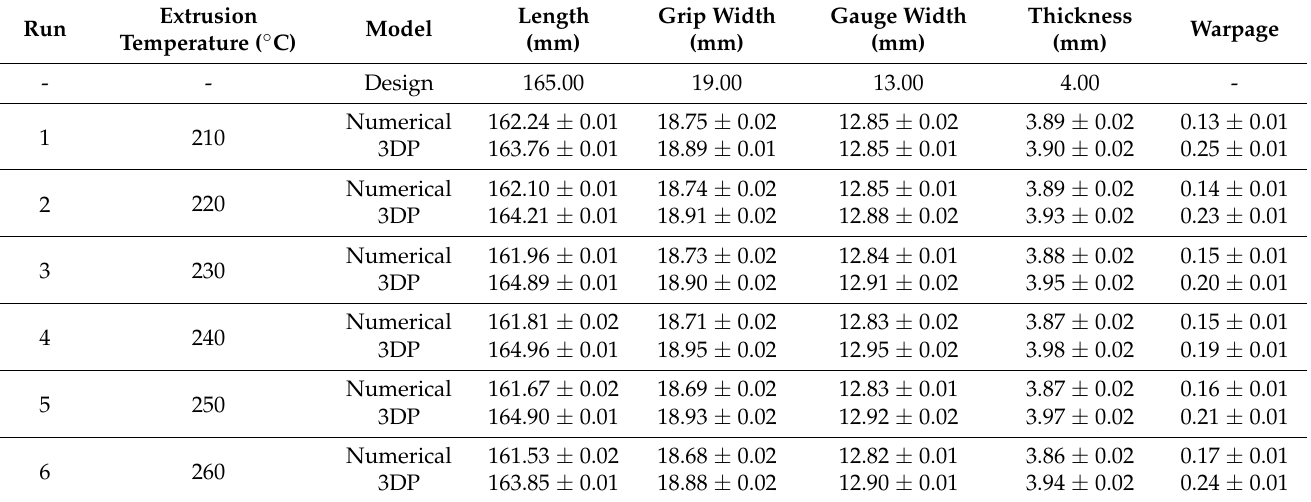
Table 1. Effect of extrusion temperature on dimensional variations in numerical model and 3DP